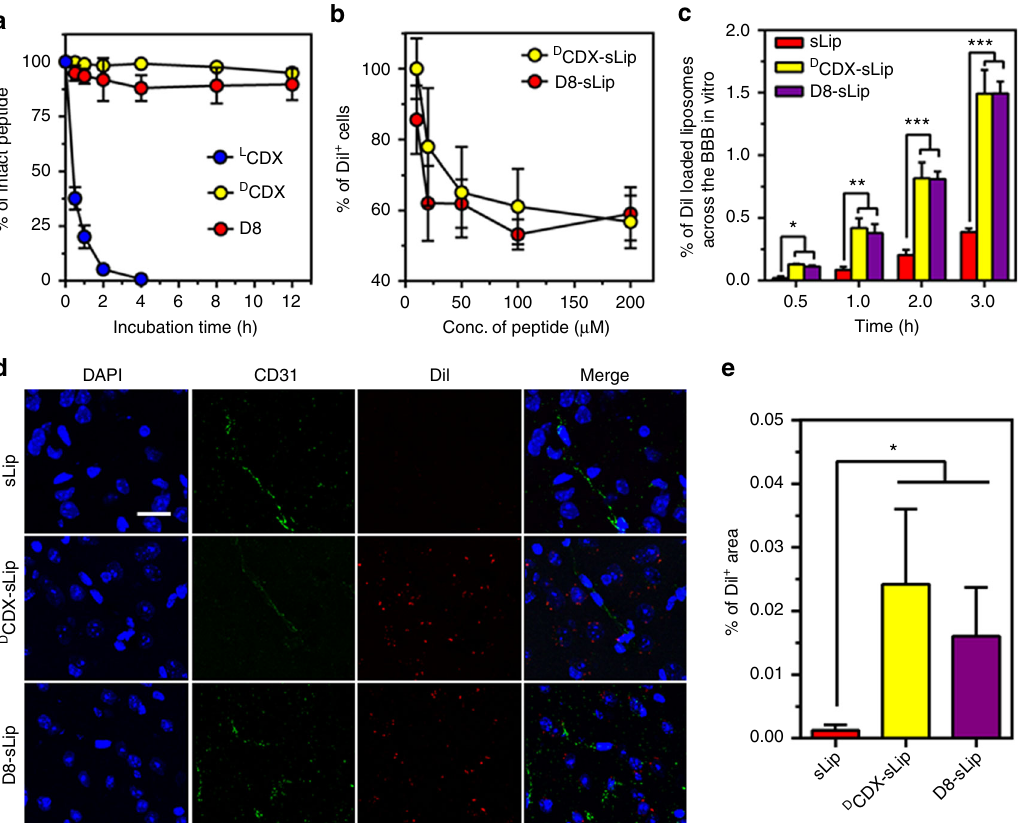
Fig. 7 Characterization of D8. a Stability in mouse serum. D8, L CDX, and D CDX were dissolved in distilled water (1 mg mL − 1 ) and were incubated with mouse serum. RP-HPLC was used to monitor and quantify peptide hydrolysis at predetermined time points. b D CDX and D8 competed the binding of DiI- loaded D CDX-Lip with Neuro 2a cells. c Transcytosis ef fi ciency of DiI-loaded sLip, D CDX-sLip, and D8-sLip across the primary brain capillary endothelial cell monolayer. d Microscopic observation of brain distribution of liposomes. BALB/c mice was injected with DiI-loaded sLip, D CDX-sLip, and D8-sLip via tail vein and brains were dissected, frozen sectioned, and stained with anti-CD31 antibody and DAPI 4 h post injection, blue — nuclei, green — blood vessels, and red — DiI dye, scale bar = 10 μ m. e Positive DiI area in three random areas were counted by Image Pro. Scale bar = 20 μ m, n = 3, data are means ± s.d. Statistical signi fi cances were calculated by Student ’ s t -test.* p < 0.05, ** p < 0.01, *** p <